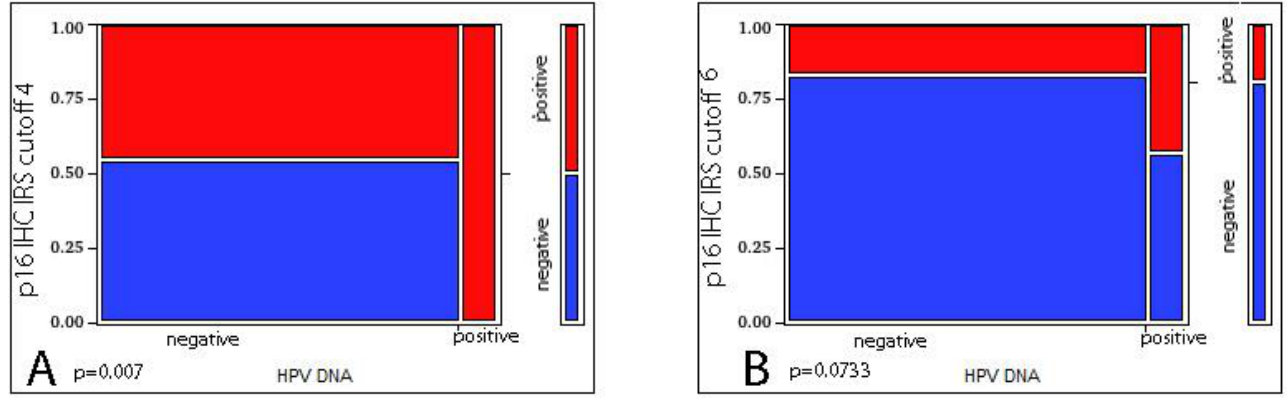
Figure 2. Correlation between p16 IHC and HPV DNA (( A ) IRS score ≥ 4 p = 0.007 at Likelihood Ratio test; ( B ) IRS score ≥ 6 p = 0.0733 at Likelihood Ratio test).